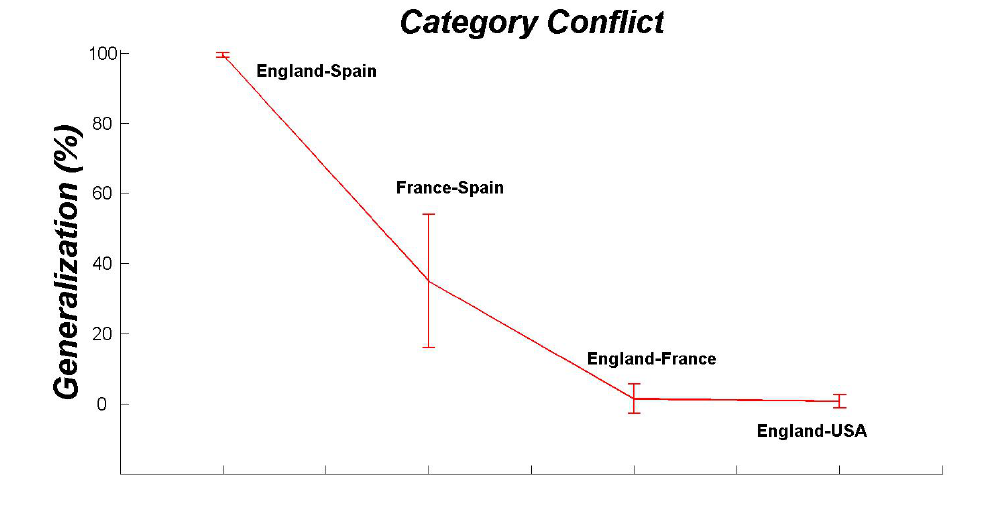
Figure 5. Generalization performance and its standard deviation (the error bars) for the category Conflict (the under-represented category). As before, the goal was to check whether the knowledge learned by the predictive model for this link (the deep network with architecture 292 × 239 × 150 × 53 × 19 × 3) might be used to generalize predictions in other links of the signed